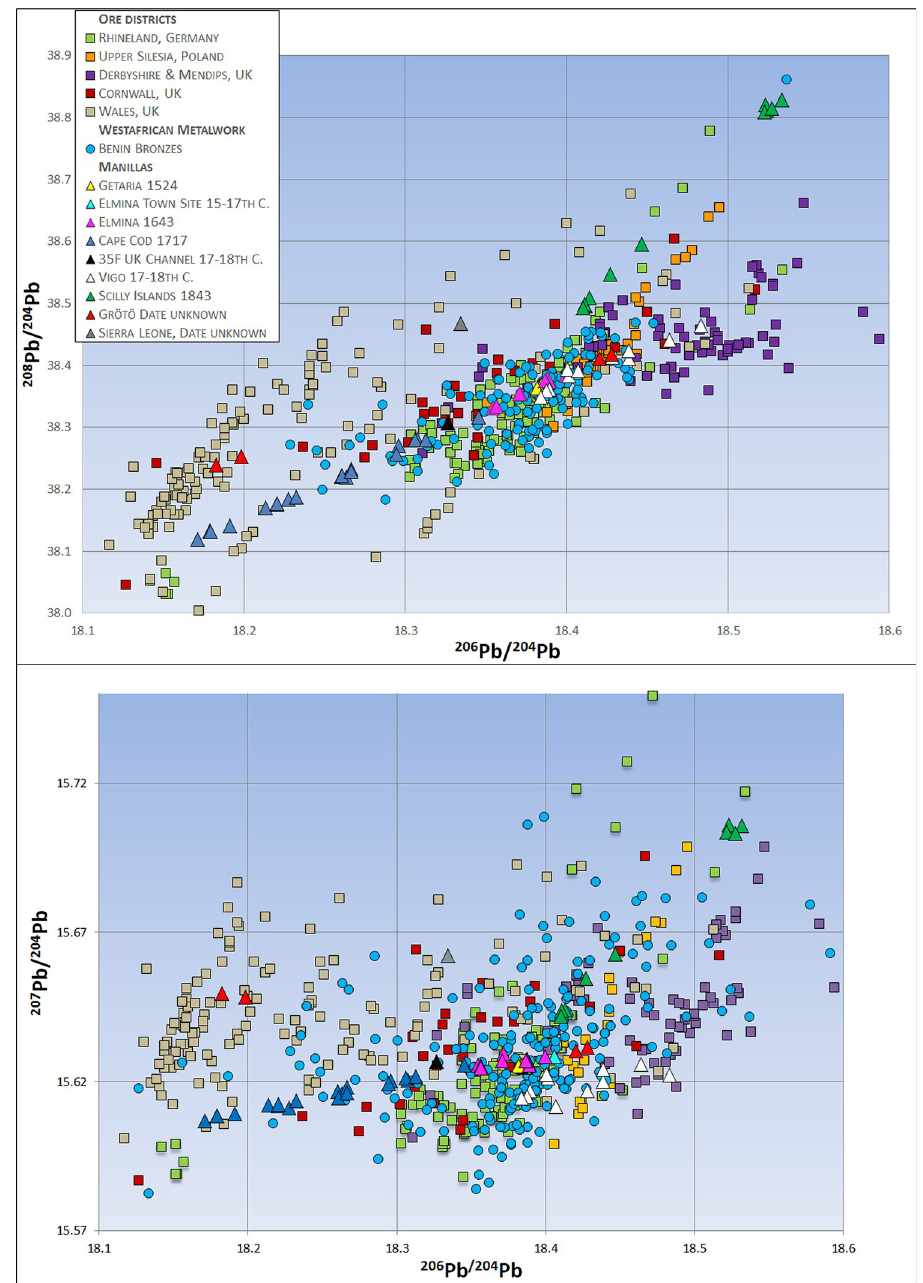
Fig 2. Lead isotope ratios 206Pb/204Pb against 207Pb/204Pb and 206Pb/204Pb against 208Pb/204Pb of various ores vs. those of Benin Bronzes and manillas of different origin and age. Only those manillas that match with the Rhenish lead-zinc ores also match the Benin Bronzes. Manillas from the 18th century onwards can be related to some of the Benin Bronzes but do not fit to the bulk cluster of the famous artworks. This bulk cluster is in good accordance with the Rhenish ores. 2sigma errors are below the size of the symbols. Data for Rhenish ores [37–43], Upper Silesia [44–46], UK Ores [47], Benin Bronzes [5], Vigo manillas [22].